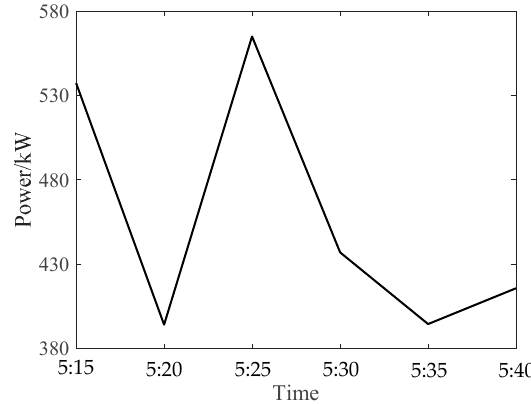
Figure 15. Sudden drop in wind energy output.